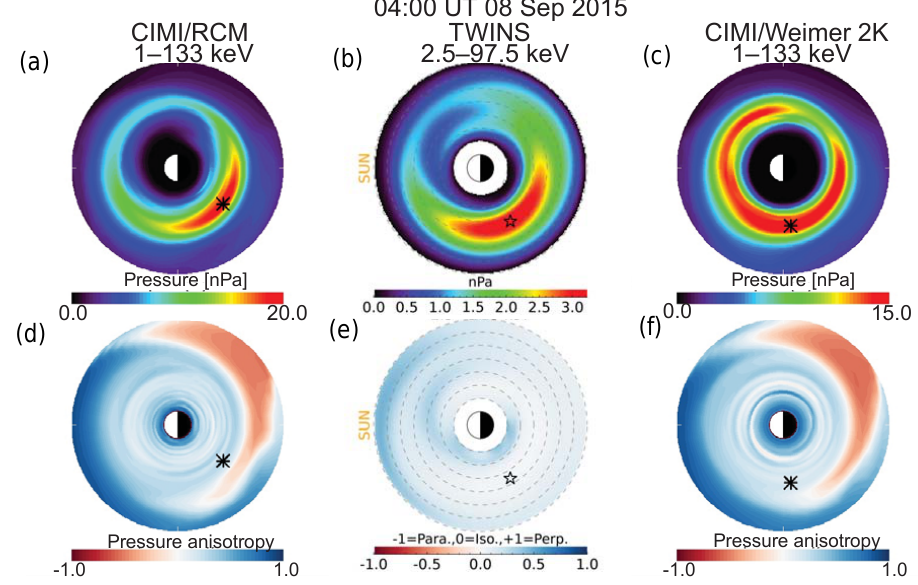
Figure 4. The ion equatorial pressure and pressure anisotropy for 04:00UT 8 September 2015 in the same format as Fig.